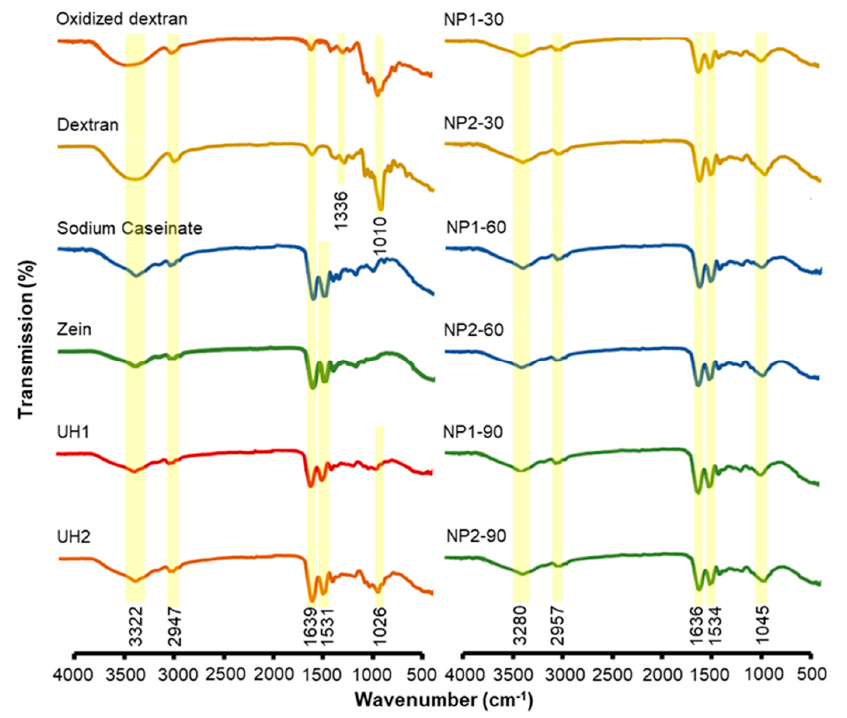
Figure 2. FT-IR spectrum of individual biopolymer and various nanoparticles prepared under di ff erent conditions and formulations.